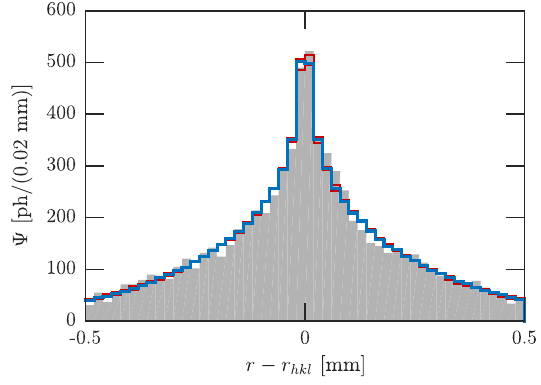
FIG. 6. Demonstration of the retrieval of an energy-dependent FIG. 5. Distributions of photons Ψ ð r Þ for diffraction by divergence with XCERP diffraction for an incident beam with the powdered silicon and an incident x-ray beam with the same same parameters as Fig. 3(a) except for an energy-dependent parameters as in Fig. 3(a) calculated: by the Monte-Carlo divergence for photons in the range 0 keV < E < 50 keV given diffraction code (grey bars); and for a Gaussian angular distri- φ ; σ by σ φ ½ mrad (cid:2) ¼ 5 − 0 . 075 E ½ keV (cid:2) . The retrieved divergence for bution Φ after least squares minimization (blue). model ð test Þ 2 . 51 (cid:3) each 10 keV energy bin is shown in blue; error bars, calculated The best fit corresponds to a divergence of σ test ¼ 0 . 08 mrad. The red lines show error bars calculated assuming assuming the number of photons detected within each energy bin are Poisson distributed, are shown by the solid red lines; the that the number of photons in each radial bin follows a Poisson standard deviation used to generate the simulation ’ s incident distribution. beam is shown by the dotted green line.